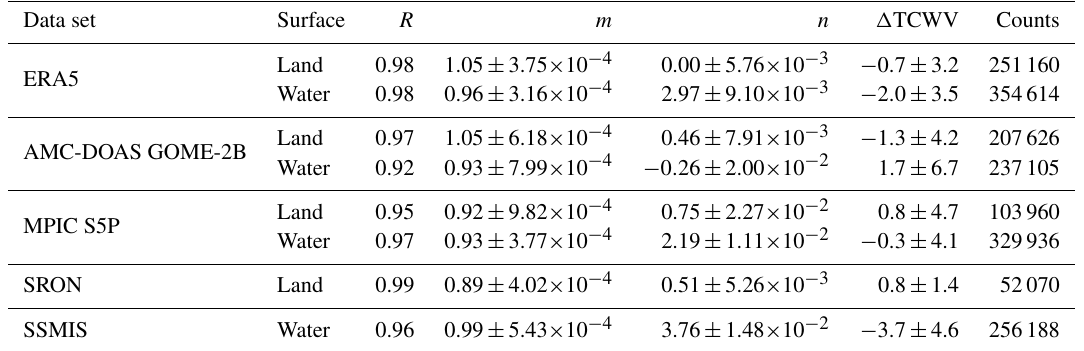
Table 2. Pearson correlation coefficient R , slope m , intercept n , average difference (cid:49) TCWV (in kgm − 2 ) to the AMC-DOAS S5P product and collocation counts for the scatter plots in Fig. 6. The errors represent 1 standard